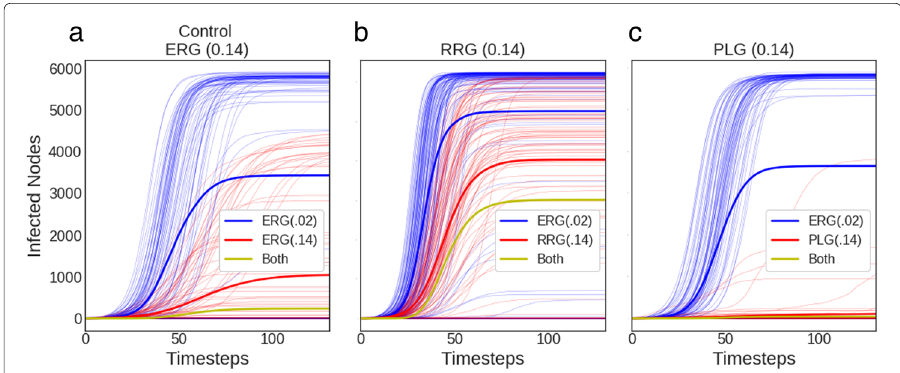
Fig. 9 In the ERG-ERG control ( a ), we observe the blue branching ( τ A = 0.02), with half the trials diffusing fully and the rest barely diffusing, evidenced by the thicker blue line near the middle. Because τ B is 0.14, the red line is much lower. In ( b ), a greater proportion of both contagions diffuse fully. Since the RRG layer diffuses faster all things equal, setting τ B > τ A means the two contagions diffuse at a similar rate, indicating synergy inhances diffusion when their rates are similar. In ( c ), since PLG contagions already diffuse slower than ERG’s, the ERG contagion penetrates similarly as the control, while the PLG barely diffuses. Here, α =